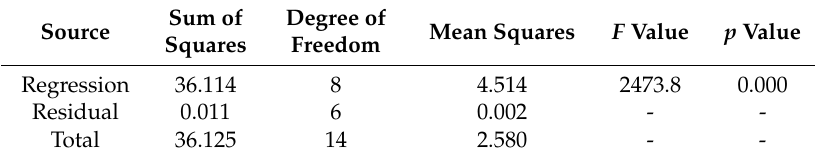
Table 10. Analysis of variance (ANOVA) for the response surface